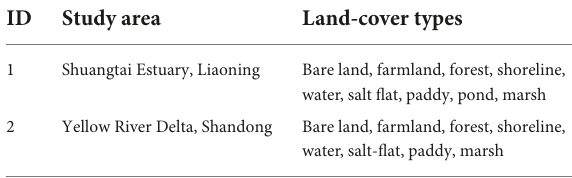
TABLE 2 The main change detection types of land-cover